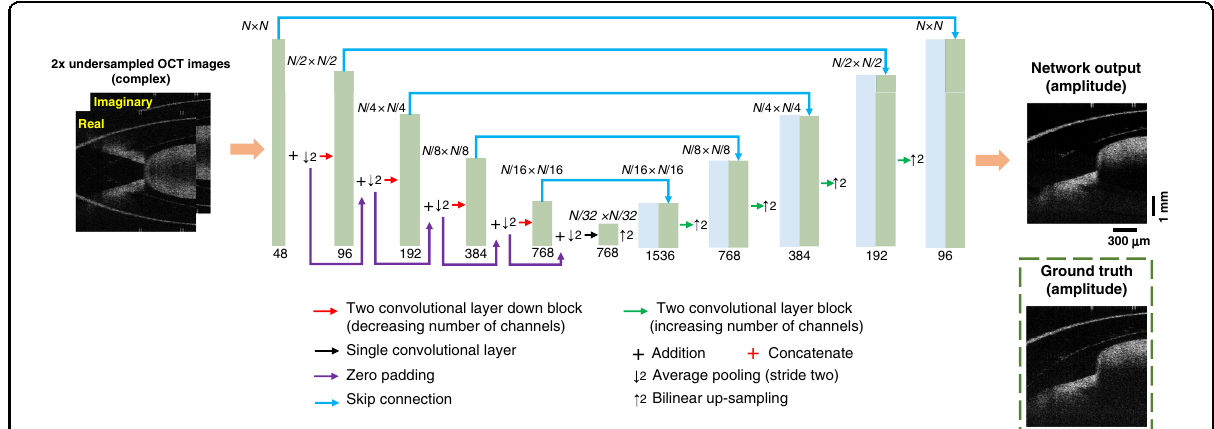
Fig. 6 Network architecture of the encoder-decoder used in DL-OCT framework. A modi fi ed U-net architecture with residual connections was used to eliminate the aliasing-related spatial artifacts due to undersampled spectral